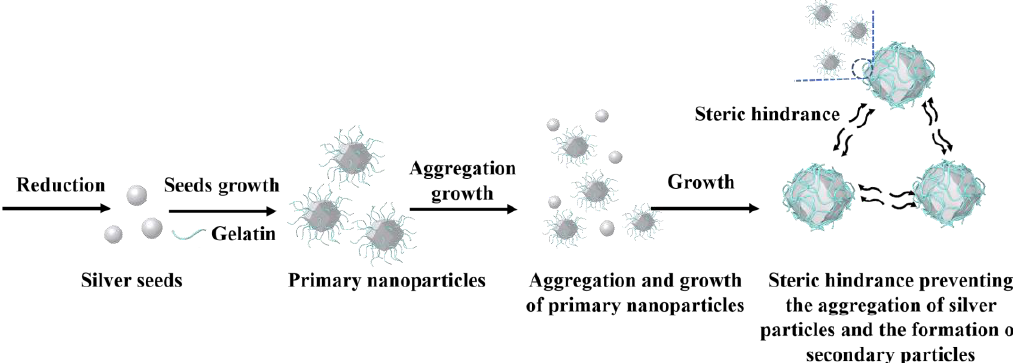
Figure 9. A schematic illustration of the proposed growth process of spherical micrometer silver particles.